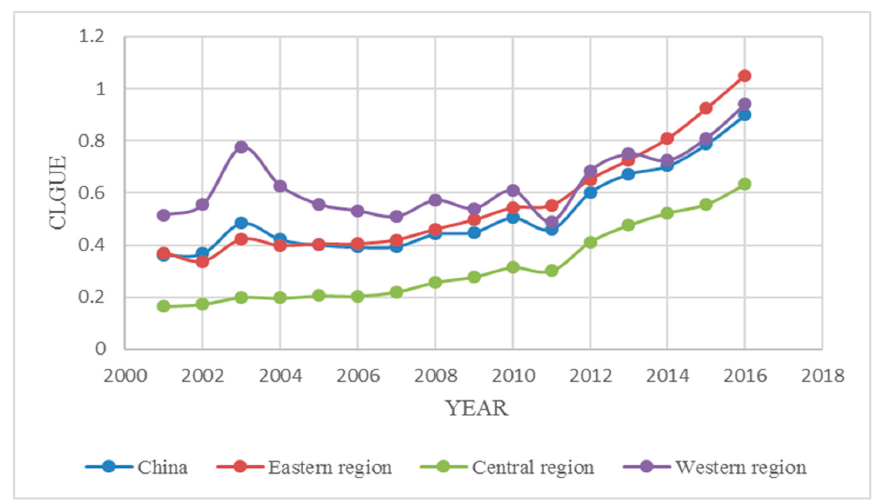
Figure 1. The GUECL fluctuating trends in eastern, middle, western and the whole of China. Note: Data in this paper were sourced from the China Statistical Yearbook, China Rural Statistical GUECL values in different provinces. The results are shown in Figure 1. Yearbook and China Demographic Statistical Yearbook from 2001 to 2016. To eliminate the influence of price factors, the total agricultural output value was converted into the constant 2001 price. As the data on OVPFA from 2013–2016 were unavailable, the data on OVPFA from 2013–2016 were calculated using the following formula: